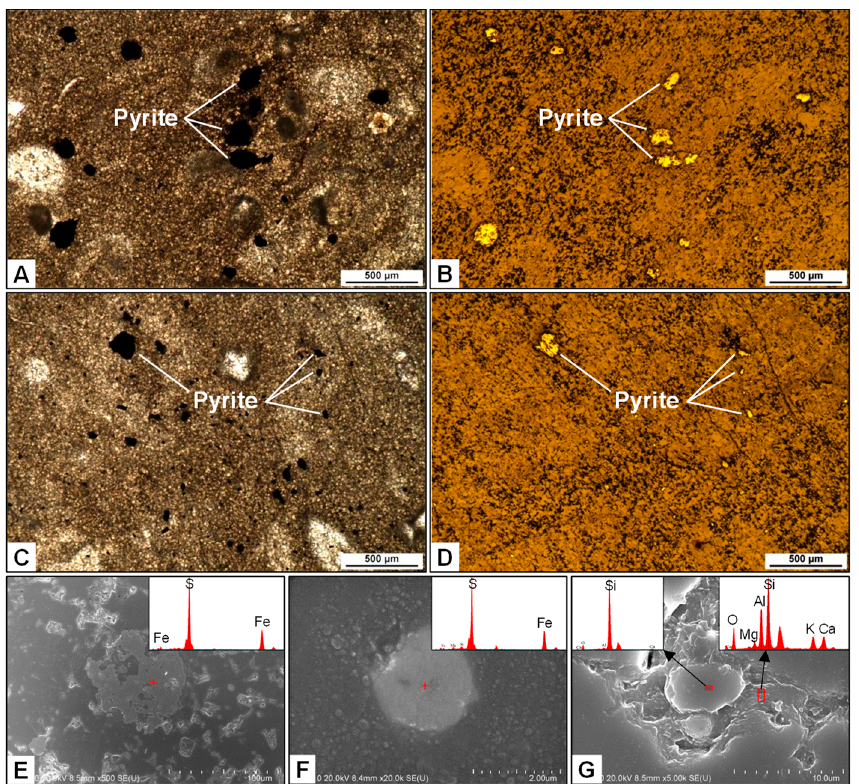
Figure 7. Thin-section and SEM photomicrographs showing pyrites and terrigenous materials near the Permian and Triassic boundary (PTB) in the well YB2. ( A , B ) Pyrites in dolomicrite, 6549.05 m, P 3 c .